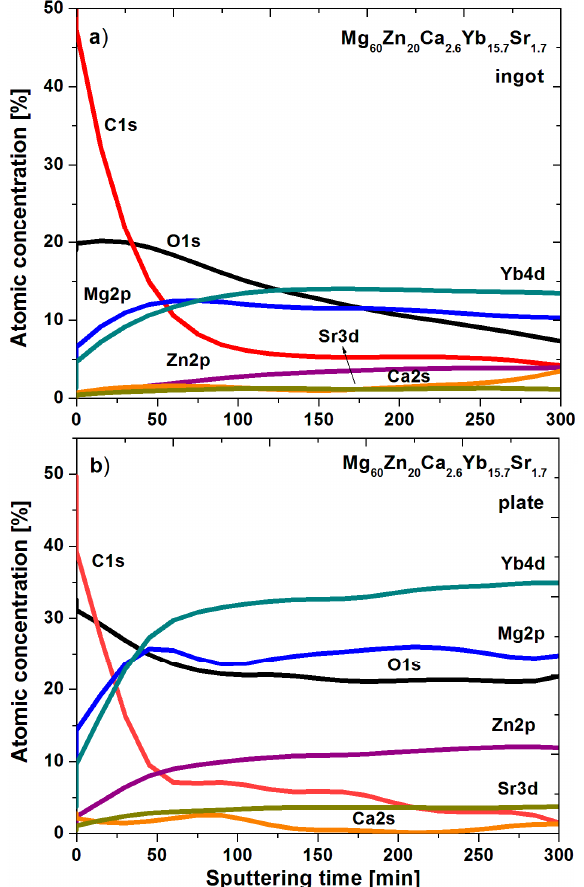
Figure 9. DP-XPS result for Mg 60 Zn 20 Ca 2.6 Yb 15.7 Sr 1.7 alloy in a form of ingot ( a ) and plate ( b ) after corrosion tests in Ringer’s solution at 37 °C.